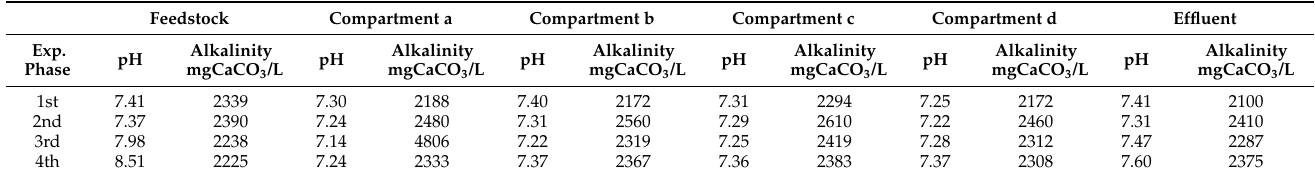
Table 7. Average daily values of pH and total alkalinity of the reactor’s feedstock, compartments and effluent.